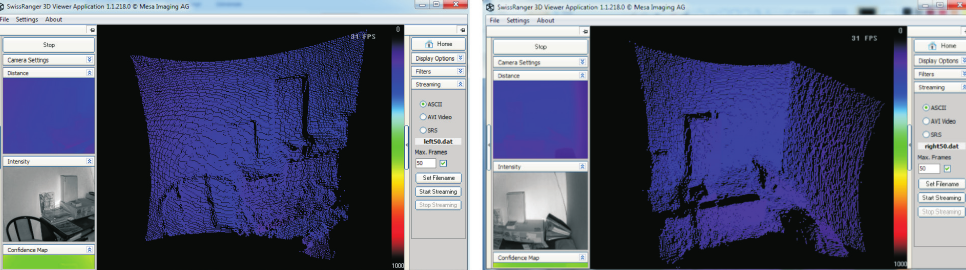
Fig. 2. The overlapping point clouds by SR4000 camera (case study 1)